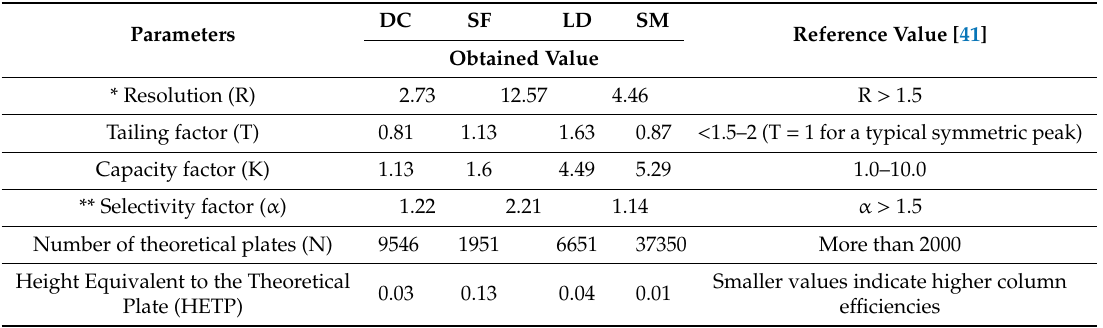
Table 2. System suitability tests for the developed HPLC method for the determination of sofosbuvir (SF), ledipasvir (LD), declatasvir (DC), and simeprevir (SM) (2.0 µ g /